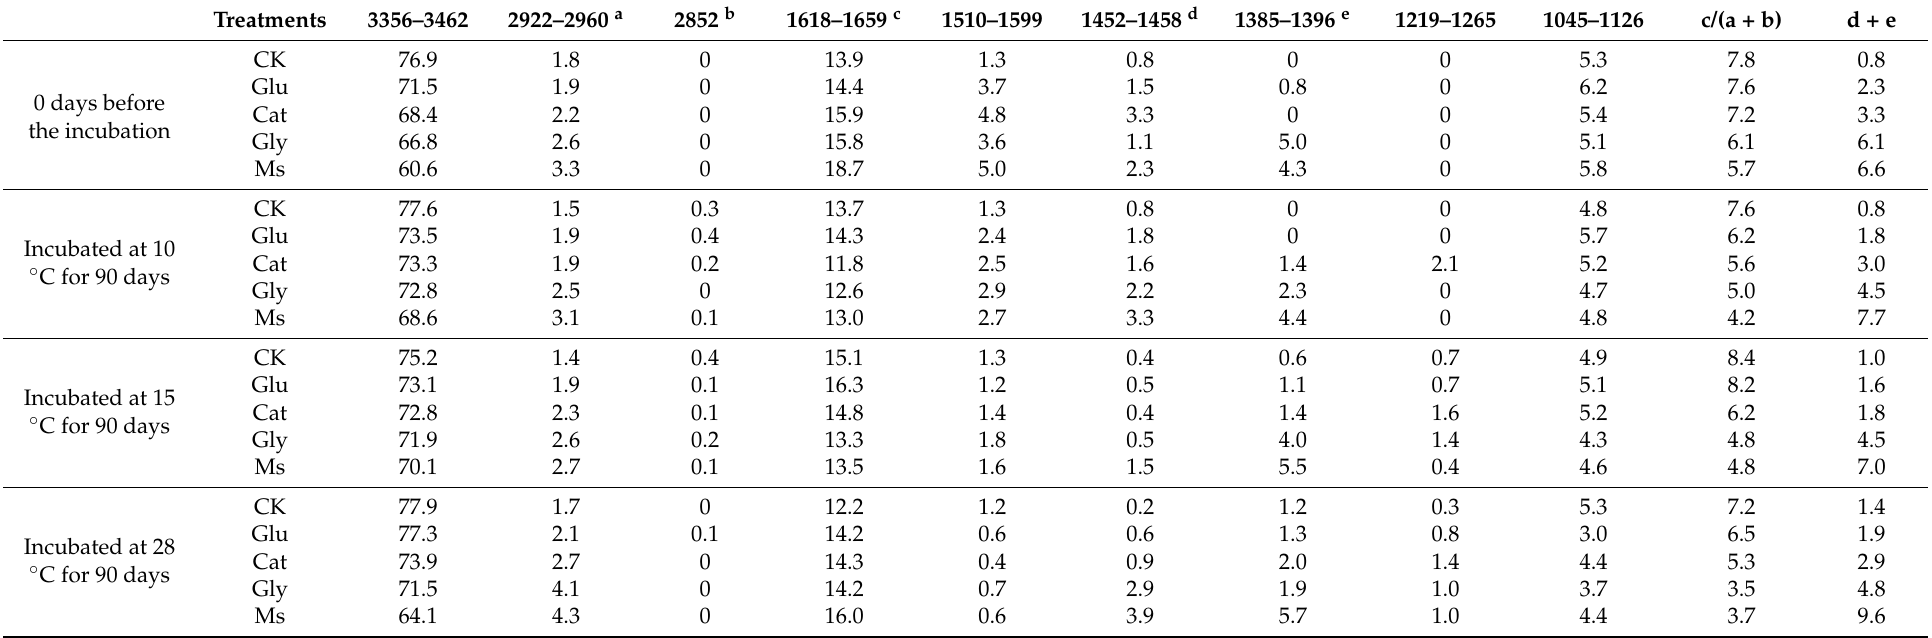
Table 2. FTIR relative intensities (% of total area) for the HLA extracted from the decomposing